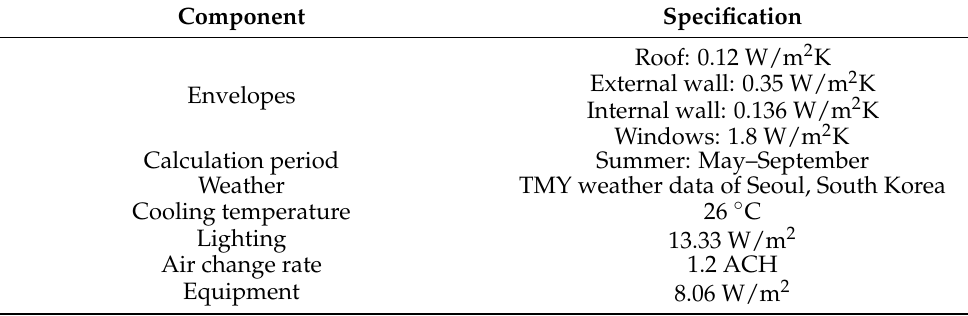
Table 2. Specifications for the energy